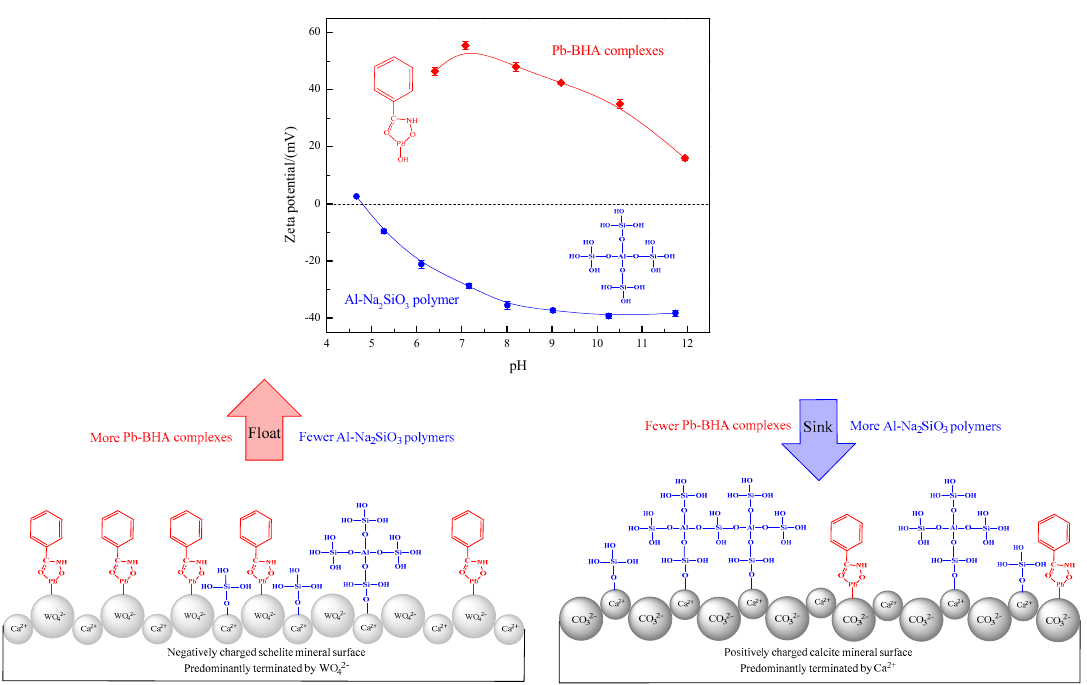
Figure 14. Adsorption model for the Al-Na 2 SiO 3 polymer and Pb-BHA complexes on the scheelite and calcite surface.